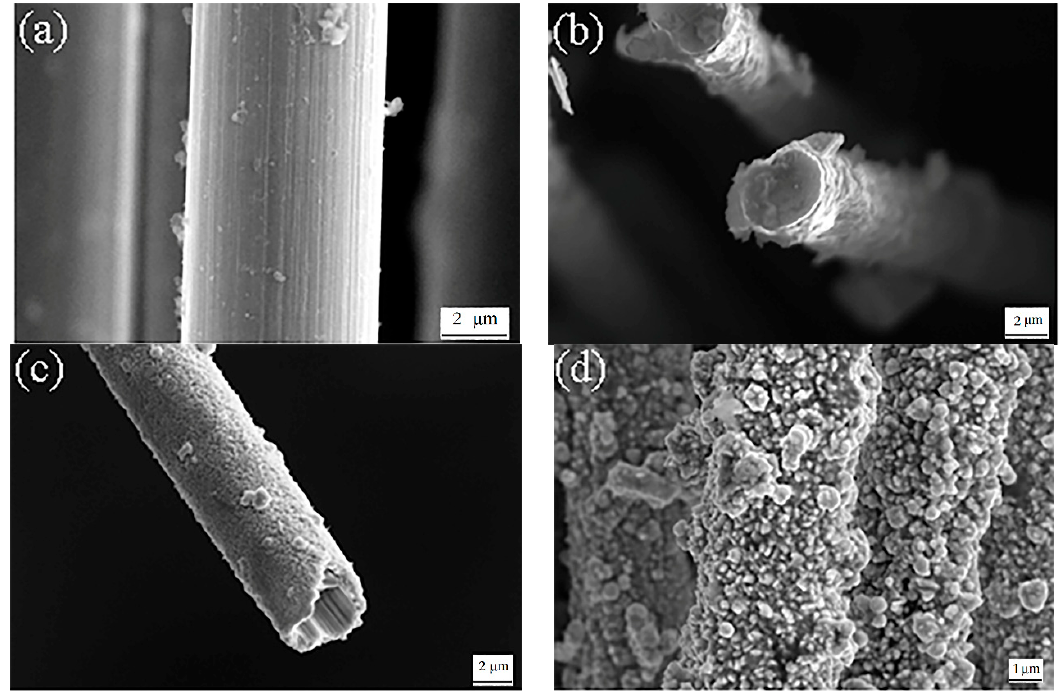
Figure 5. The surface morphology of copper deposits on carbon fibers at different pH value in the solution: ( a ) pH 10; ( b ) pH 11; ( c ) pH 12; ( d ) pH 13.